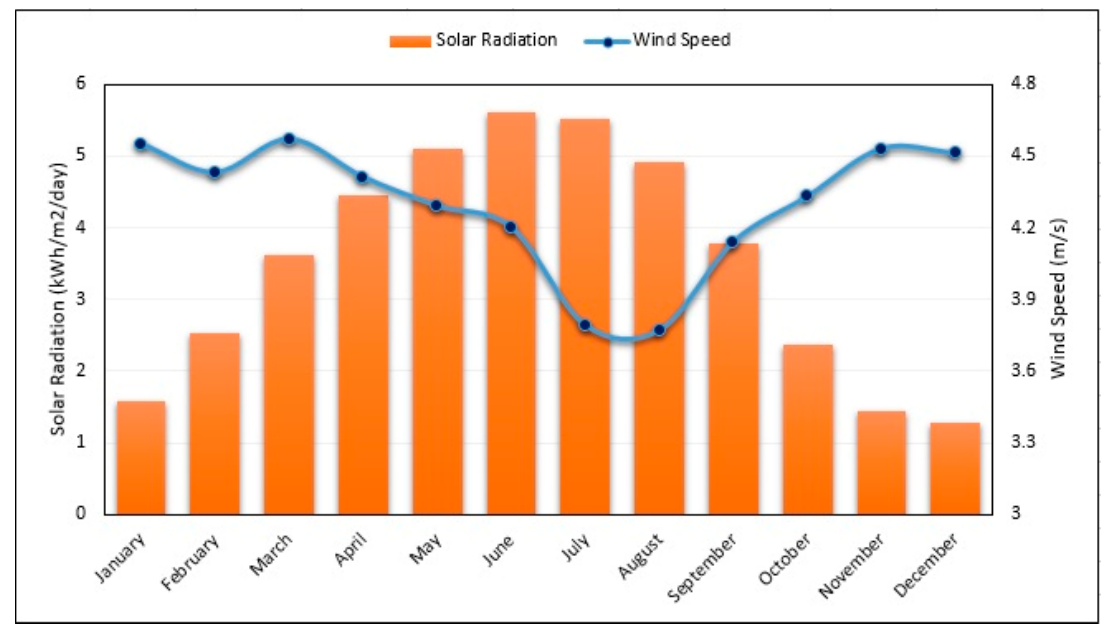
Figure 3. Average solar radiation and wind speed during the year in Montreal .